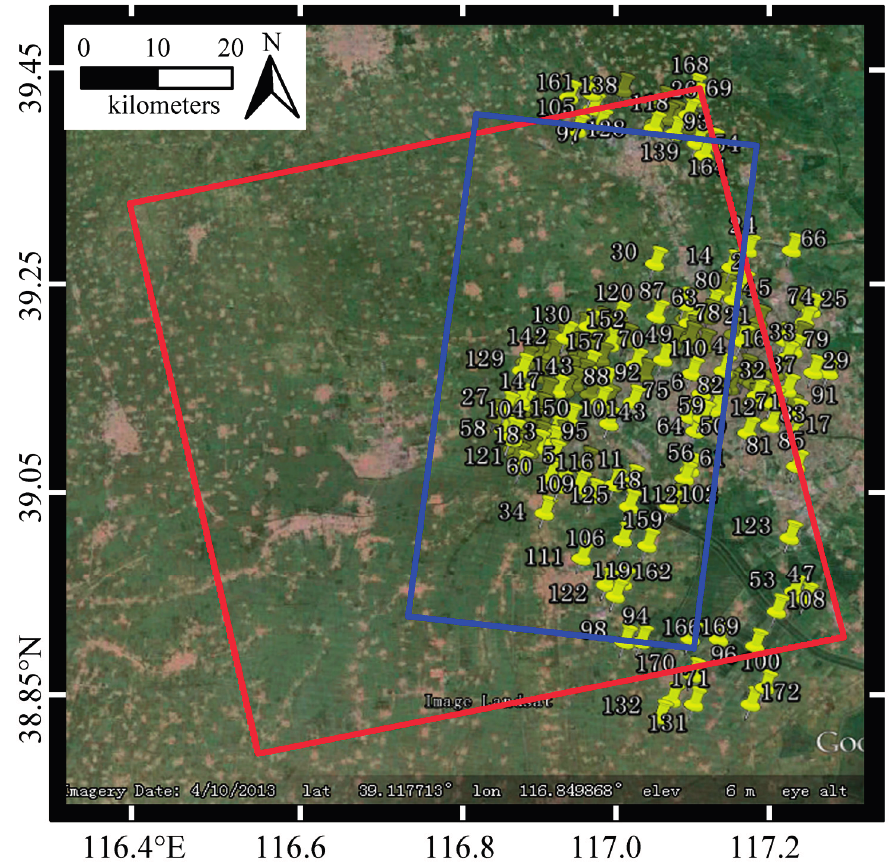
Figure 5. Locations of leveling points. Red frame represents ALOS-PALSAR coverage and blue TSX